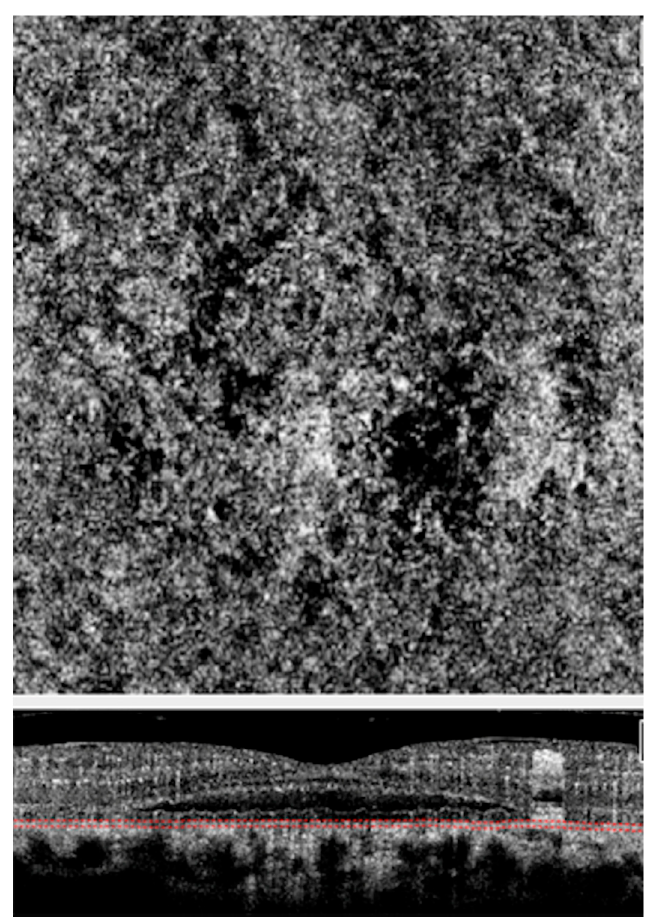
Figure 5. Optical coherence tomography angiography (OCTA) of an eye with CSCR. Choriocapillaris slab ( Above ) of OCTA scan above showing choriocapillaris flow void areas (dark areas) and corresponding cross-sectional scan ( Below ) showing the scan location at the choriocapillaris level.